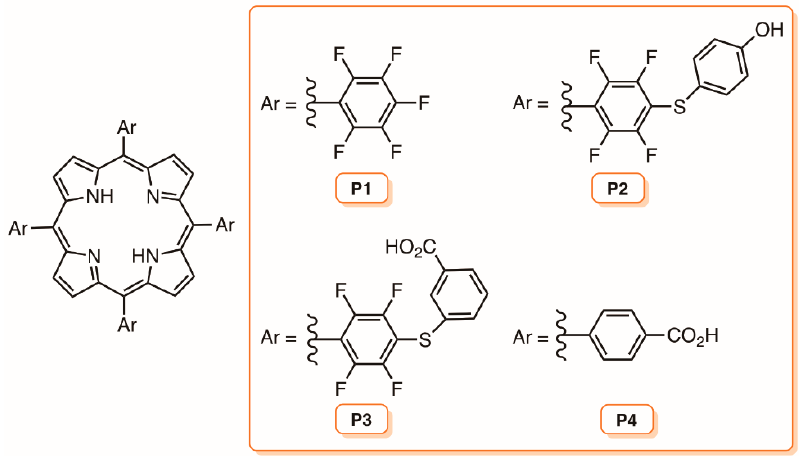
Figure 19. Structure of meso -tetraarylporphyrin P1–P4, bearing phenyl or pentafluorophenyl groups at the meso positions with or without acid groups used to prepare chitosan films (adapted from Reference [109]).